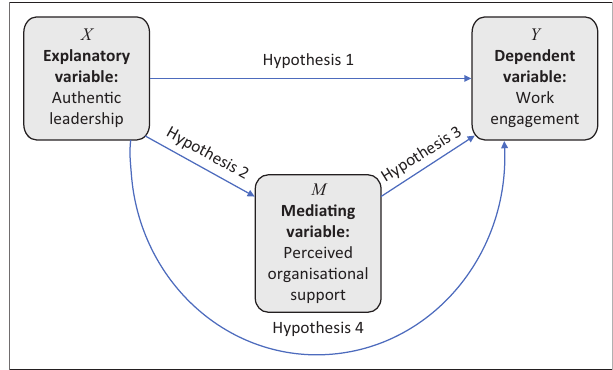
FIGURE 1: Conceptual framework with